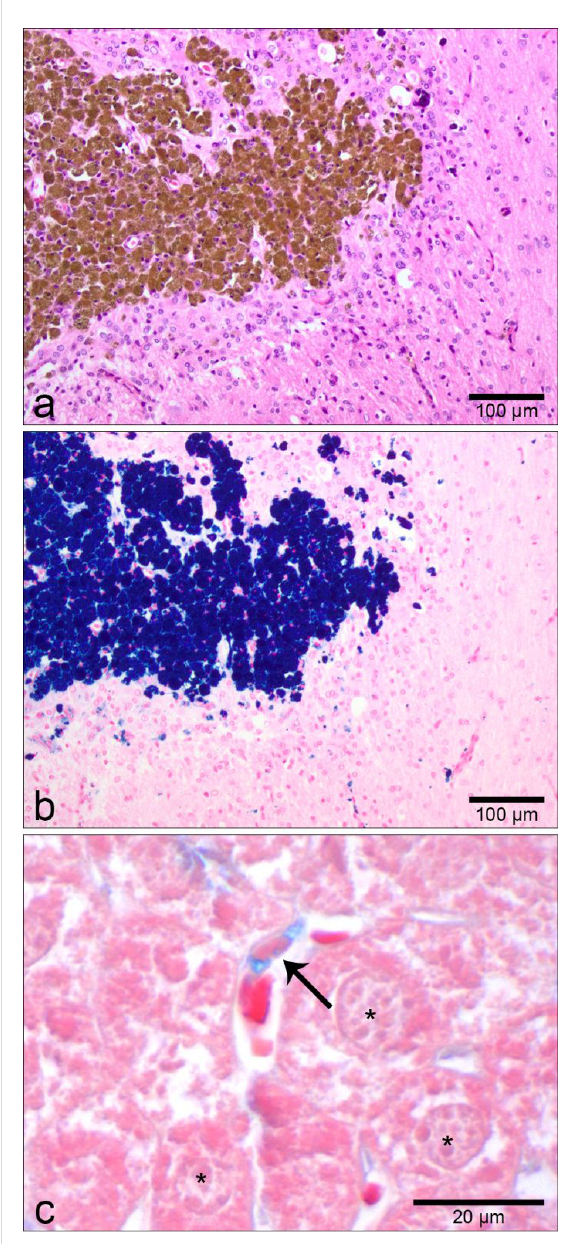
Figure 1: Nanoparticles may be detected through light microscopy by using chemical staining protocols that are conventionally employed in histopathology. For example, clusters of iron oxide nanoparticles can be visualized in HE-stained tissue sections as a finely granular brown material within the cells of a glioblastoma tumor (a, with kind approval of MagForce AG, Berlin, Germany). When serial sections from the same tissue were stained with a canonical stain for iron, Turnbull blue, the particles appear dark blue (b). As a second example, Alcian blue stain may be used to stain dendritic polyglycerol sulfates (dPGS) due to their negatively charged, sulfate rich shell. Organic dPGS amine accumulated in the cytoplasm of hepatic Kupffer cells (c, arrow). These liver specific macrophages are identified by their comma-shaped nuclei and their lining of hepatic sinusoids. Adjacent hepatocytes (c, aster- isks) appear as light pink cells with finely stippled cytoplasm whereas erythrocytes within sinusoids can be identified by their intensely pink